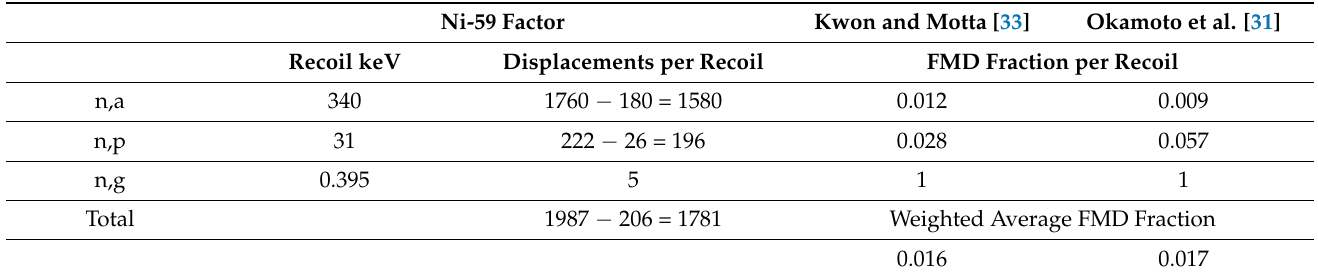
Table 1. FMD fractions for 59 Ni reactions using different formulae. Note that the total number of displacements shown below includes the damage from the recoil only. Ni-59 Factor Kwon and Motta [33] Okamoto et al. [31] Recoil keV Displacements per Recoil FMD Fraction per Recoil 1760 − 180 = 1580 0.012 0.009